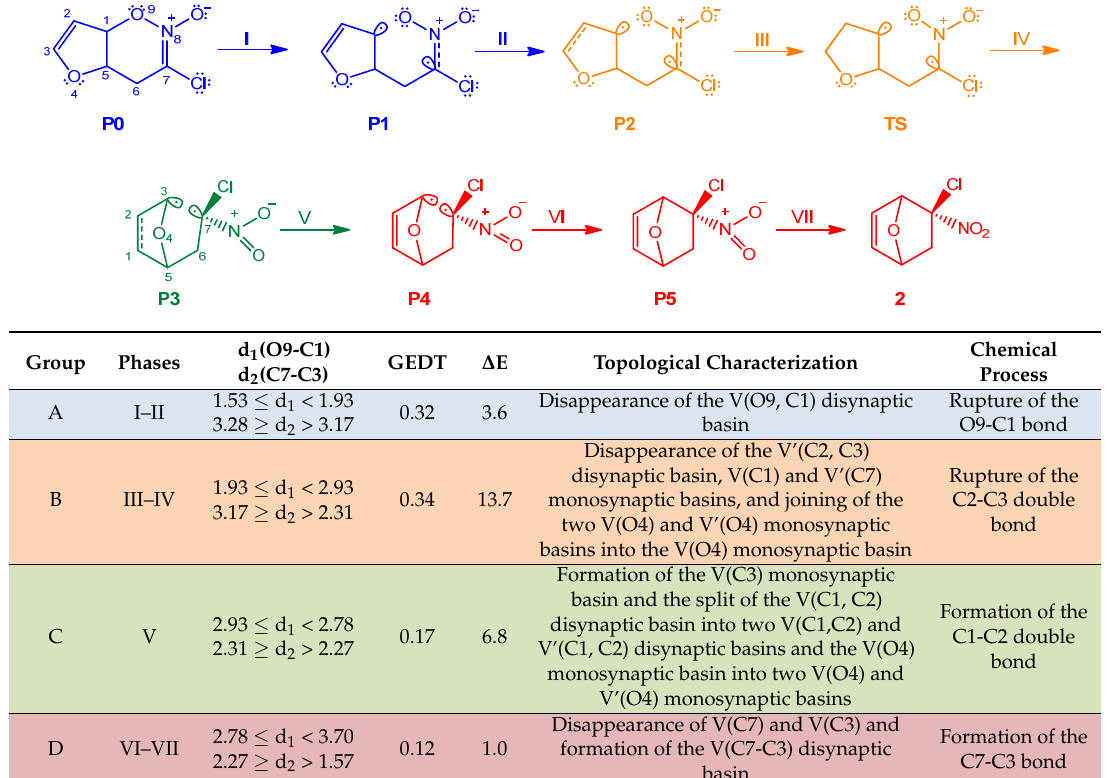
Table 2 . Sequential bonding changes along the rearrangement of the 1 into 2 , showing the equivalence between the topological characterization of the different phases and the chemical processes occurring along them. Distances are given in angstroms, Å, GEDT values in the average number of electrons, [e], and relative energies in kcal · mol − 1 .